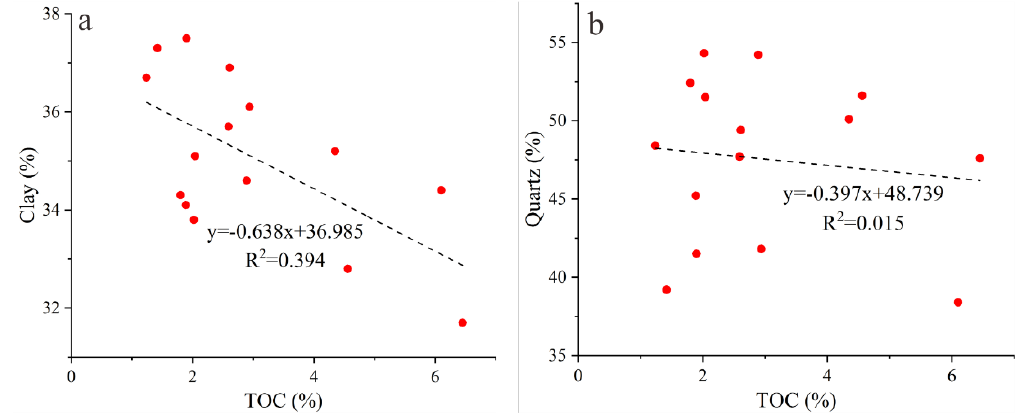
Figure 10. Relationships between TOC and clay ( a ) and quartz ( b ).